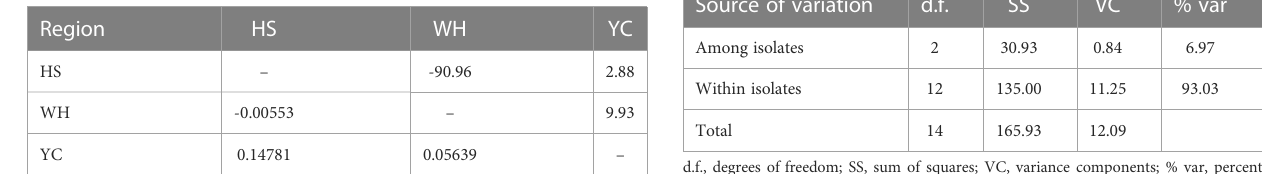
d.f., degrees of freedom; SS, sum of squares; VC, variance components; % var, percentage of variation; P, probability of a random variance component value ≤ observed value; ns, non- signi fi cant.